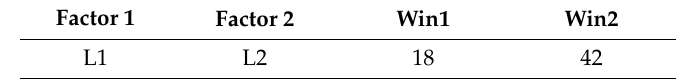
Table 10. Input file of Learning and Growth (L) factors preferences in a win-to-loss context. Factor 1